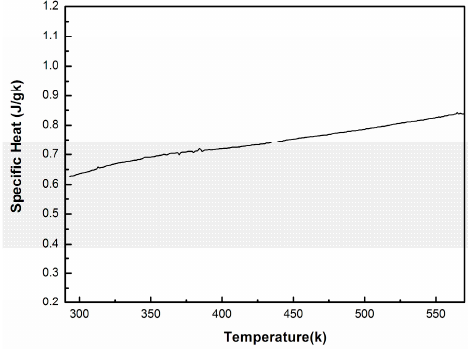
Figure 5. Specific heat curve of the Mg: 7 LiNbO 3 crystal.